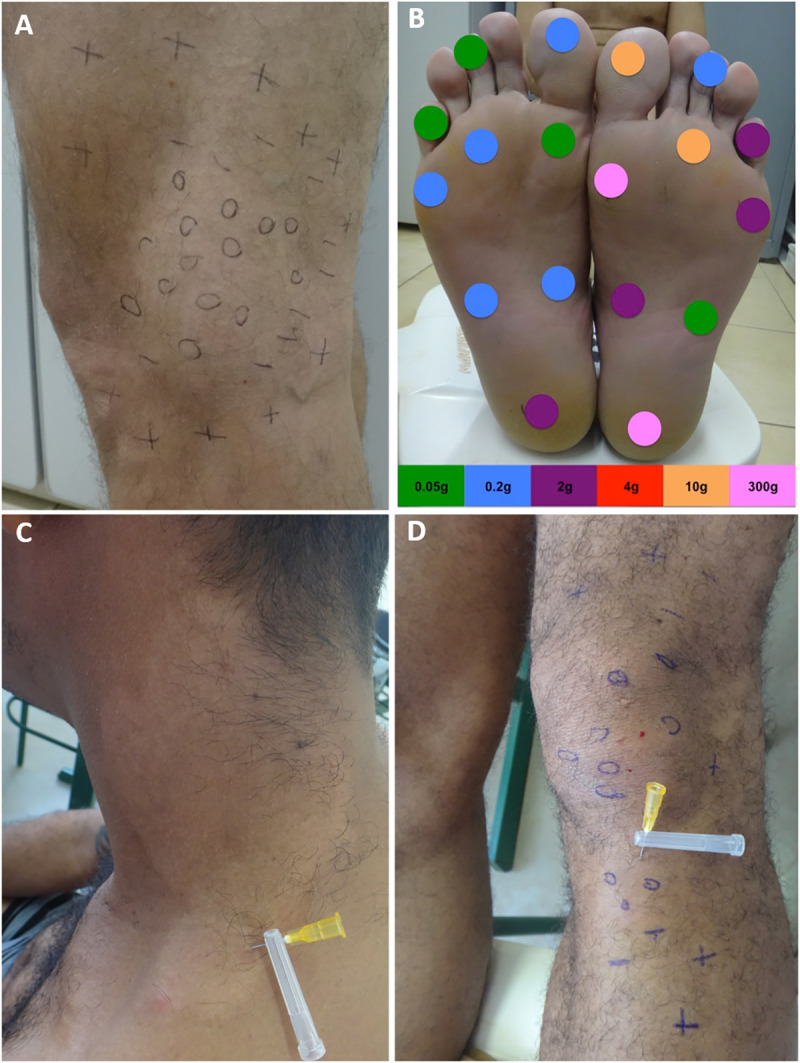
(a) Hypochromic, hypo-anesthetic macule on the left knee with loss of tactile sensitivity; (b) assessment of feet for touch sensitivity with the Semmes-Weinstein monofilaments test; (c) hypochromic and anesthetic to pain sensitivity, an anhidrotic macule on the neck; (d) multiple hypochromic and hypo-anesthetic to thermal, tactile and pain sensitivities, macule with localized irregular patches of circumscribed hair loss on the left lower limb. 0 (anesthetic point);—(hypoesthetic point); + (normoesthesic point).